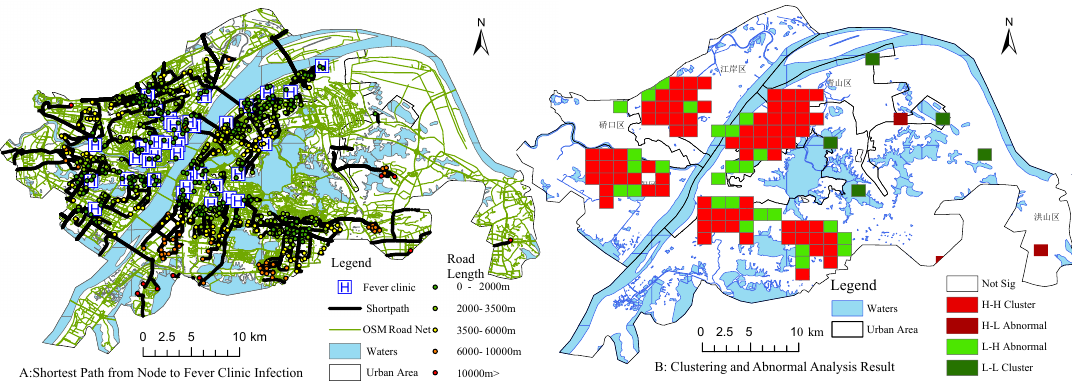
Figure 6. Spatial analysis of the epidemic community. ( A ) Shortest distance and shortest path from node to fever clinic infection. ( B ) Clustering and abnormal analysis ( p = 0.05 confidence level).